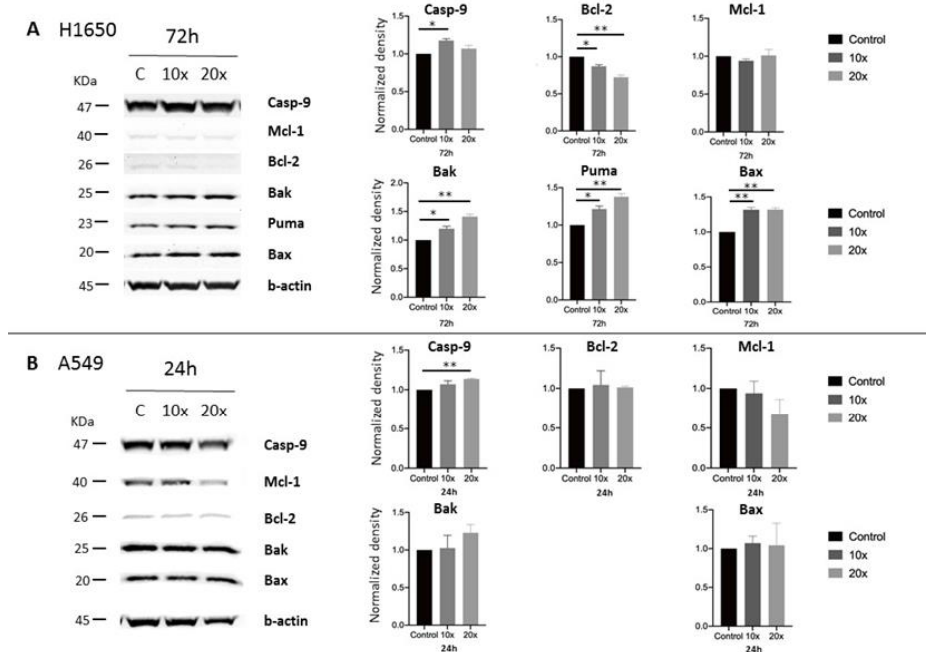
Figure 6. Western blot analysis of apoptotic proteins in methyl-donor treated A549 and H1650 cell lines. Clear opposite changes of pro-apoptotic vs. anti-apoptotic proteins were seen in both lung cancer cell lines. In H1650 cells, all protein changed significantly after the treatments, except the Mcl-1 ( A ). In A549, only the Caspase-9 increased significantly ( B ). Each bar represents the average normalized density from at least 3 repeats ± SD. Statistical significance is plotted as *: p < 0.033, **: p < 0.002. C: control; Casp-9: Caspase-9. × 10 and × 20: concentrations of methyl-donors.